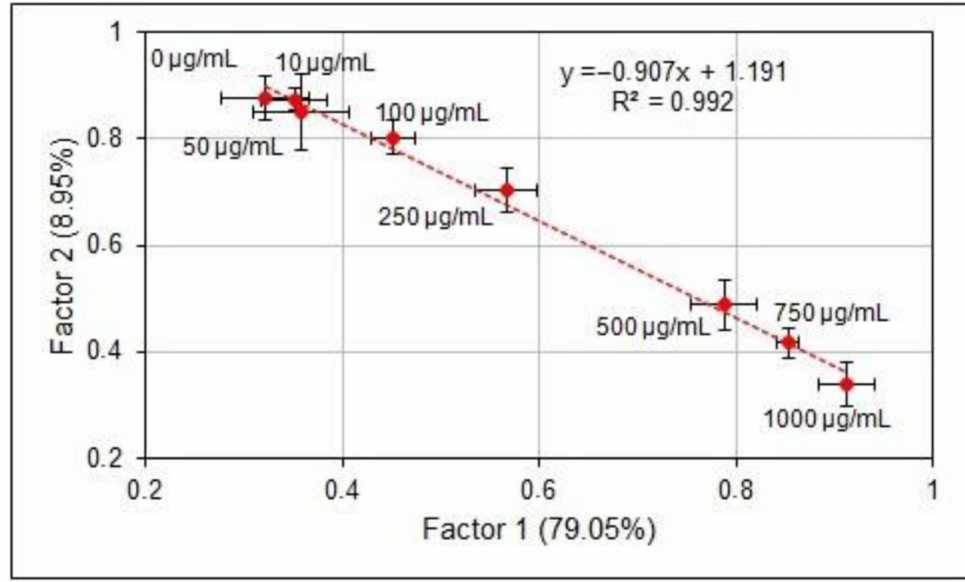
Figure 5. The Ca LIBS spectra in the FA